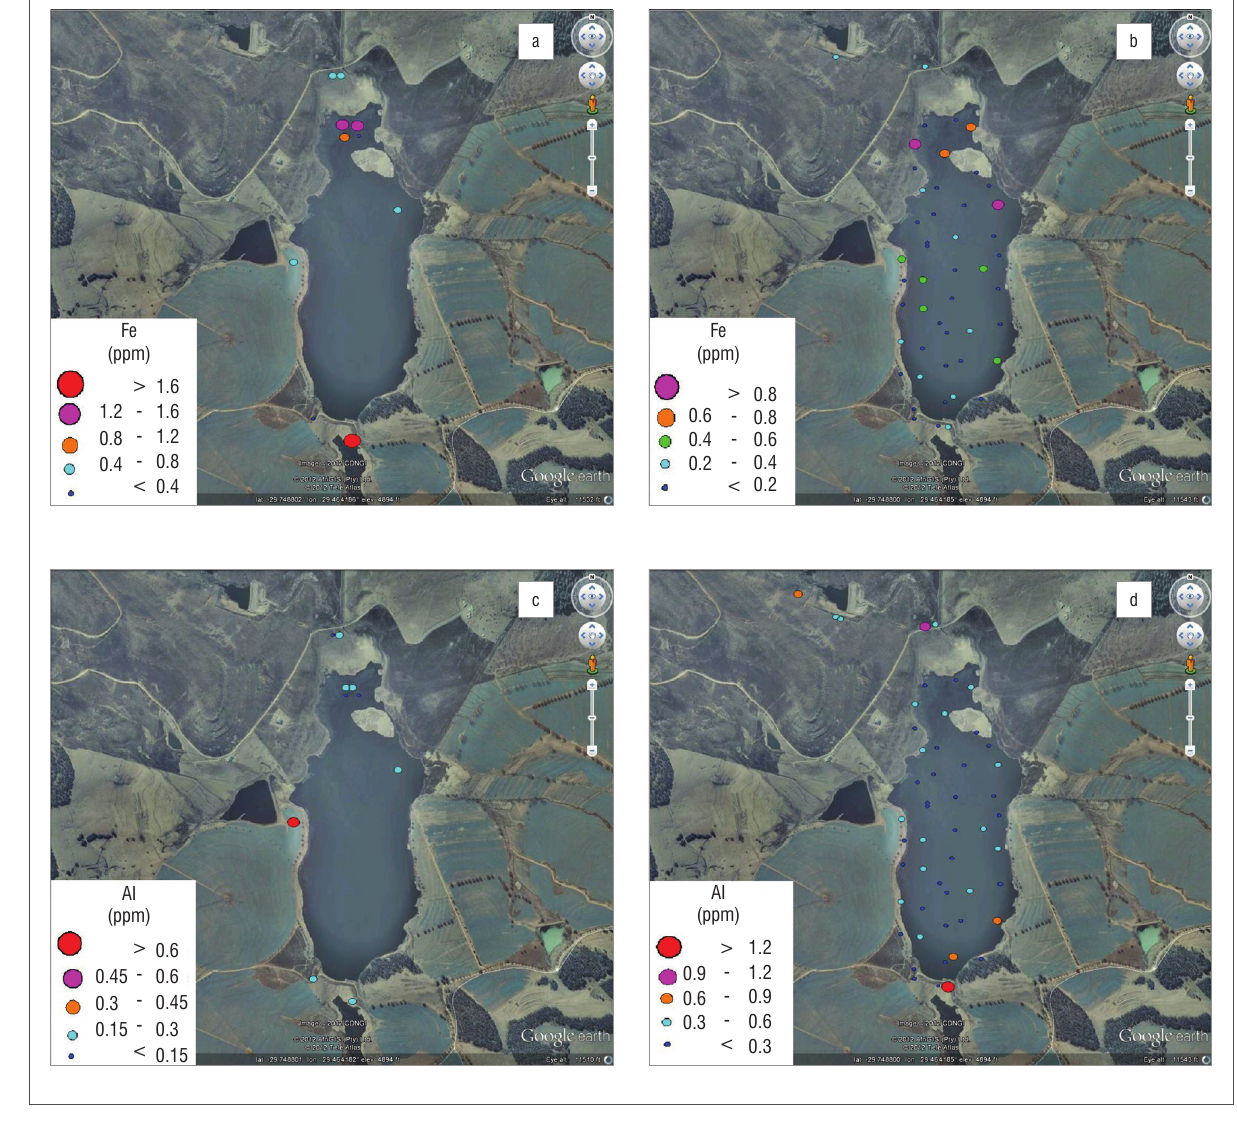
Figure 6: Proportional symbol map showing the distribution along Bonsma Dam of the concentrations of iron in the (a) wet season and (b) dry season and of aluminium in the (c) wet season and (d) dry